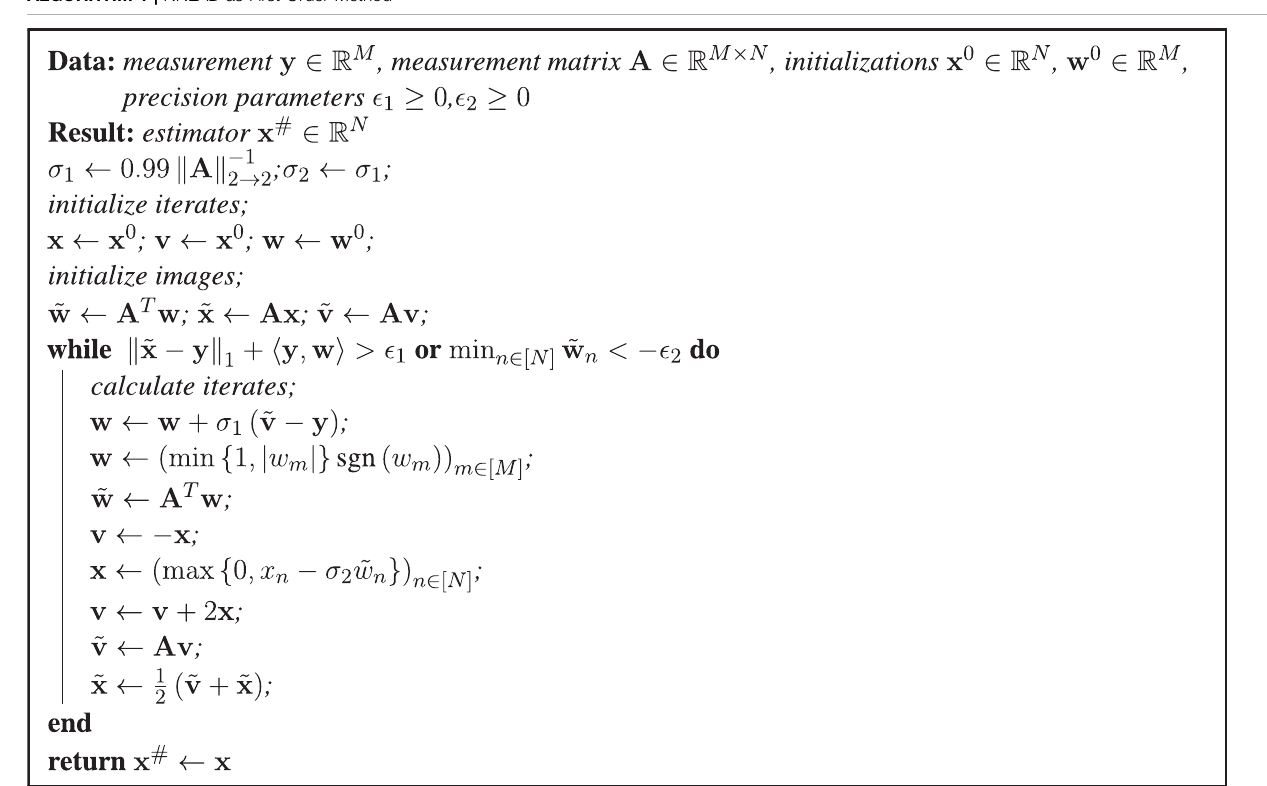
ALGORITHM 1 | NNLAD as First Order